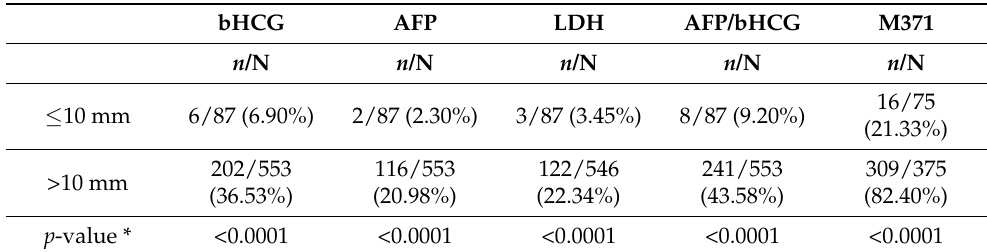
Table 10. Serum tumour marker expression rates stratified by tumour size categories in the entire population of patients with testicular tumours (SE, NS, BT, OM).